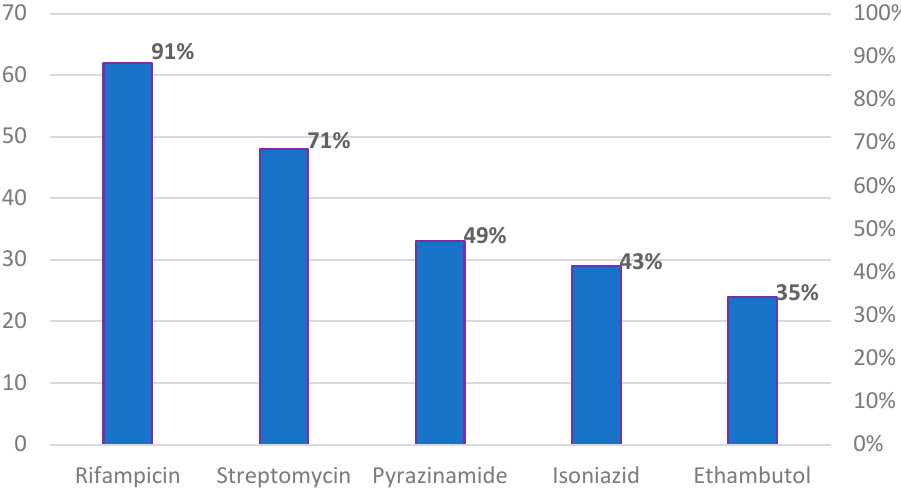
Figure 1. Reported sale of first-line anti-TB drugs for the treatment of cough among PMVs and CPs, n = 68. Multiple responses allowed.